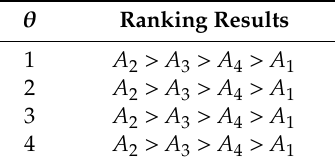
Table 9. The evaluation results a ff ected by di ff erent θ attenuation coe ffi cients. θ